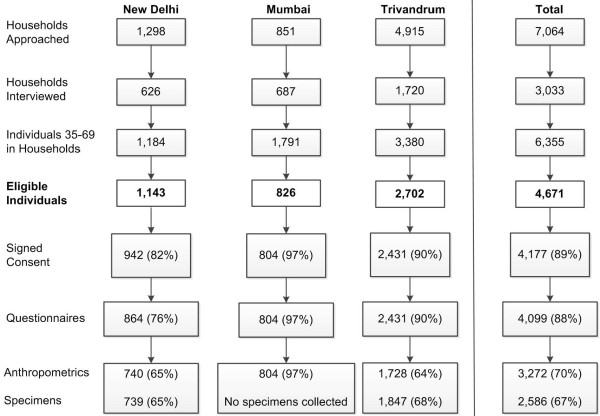
Individual center and total response rates.